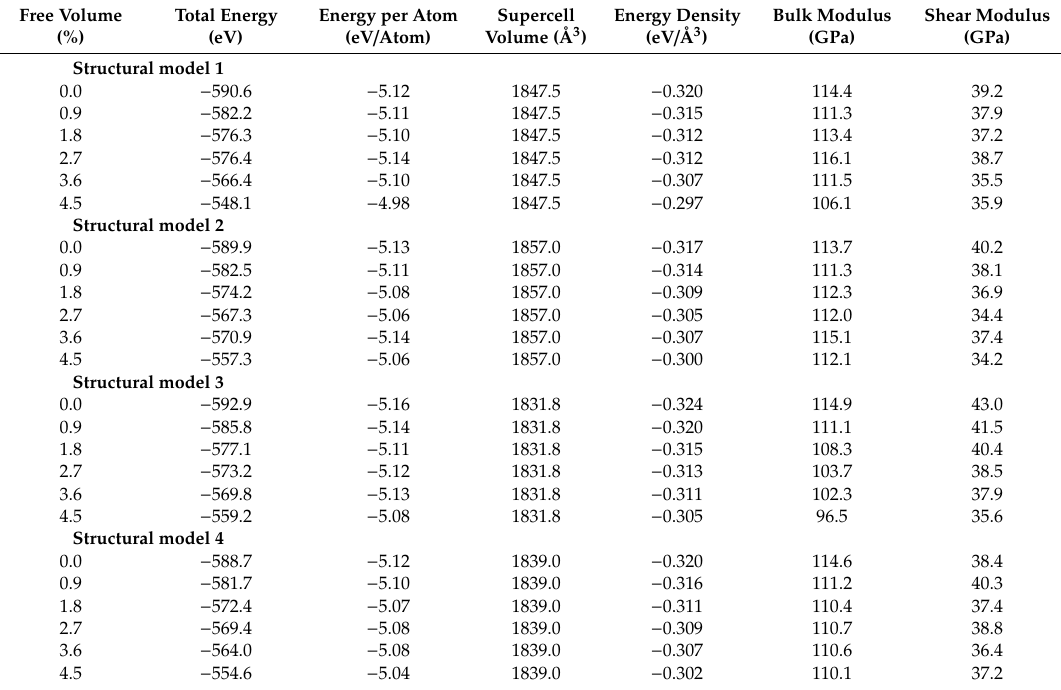
Table 1. Free volume, total energy, energy per atom, supercell volume, energy density, and bulk and shear modulus of the four structural models developed in this